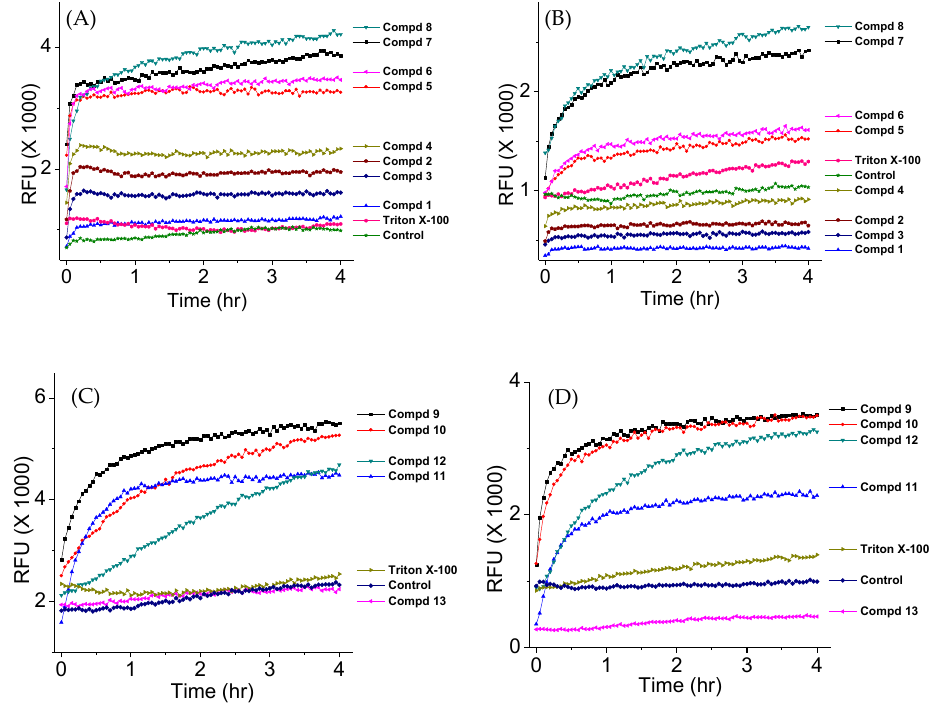
Figure 6. Kinetic membrane permeabilization of C. neoformans H99. ( A ) Cells treated with 4″,6″-diaryl AKs using SYTOX TM green; ( B ) cells treated with 4″,6″-diaryl AKs using PI; ( C ) cells treated with 4″,6″-dialkyl AKs using SYTOX TM green; ( D ) cells treated with 4″,6″-dialkyl AKs using PI. The figure with standard deviation is available in Supplementary Materials.